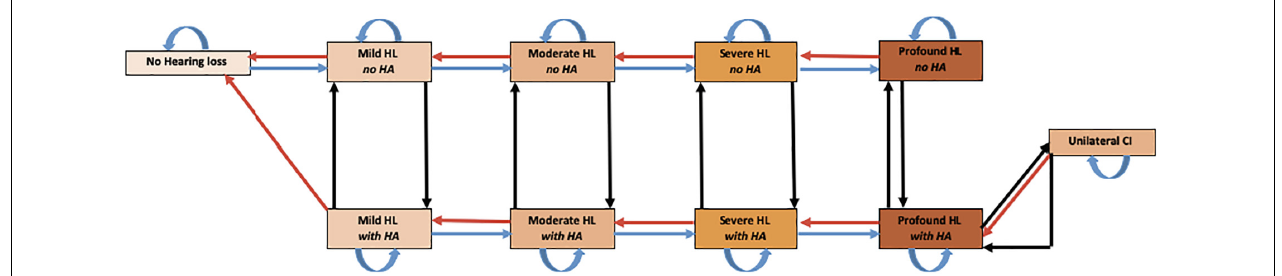
FIGURE 1 | Markov Model of health states used to assess regenerative hearing loss therapeutics. The model starts with a cohort of 50-year-old patients with various degrees of HL. Every cycle subjects could progress to 1 of 11 mutually exclusive disease states including death. Though movement is possible between every state, natural death and all arrows not depicted for simplicity. HL, hearing loss; HA, hearing aid; CI, cochlear